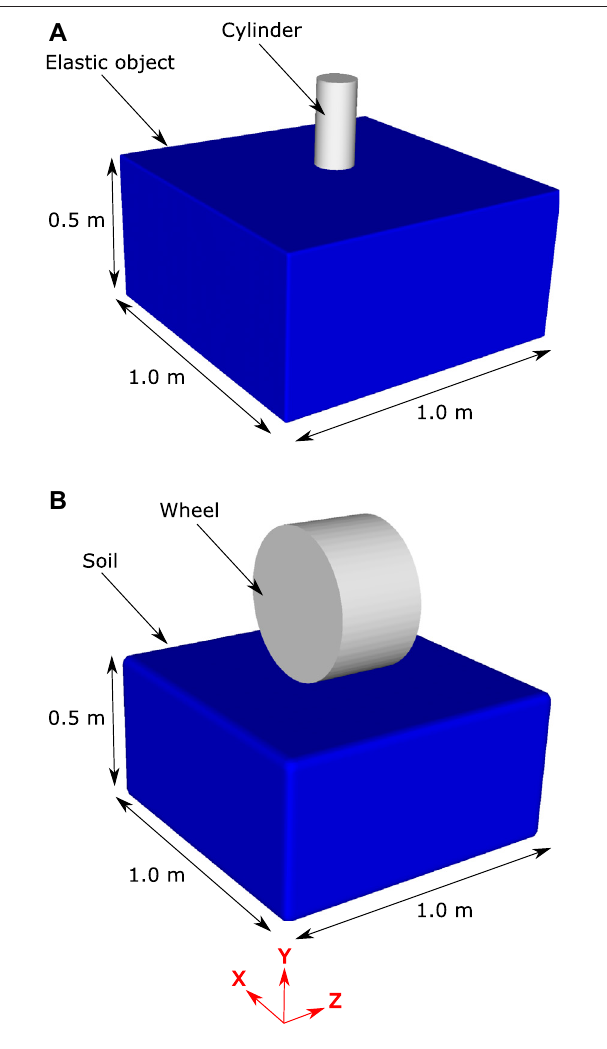
FIGURE 4 | The two simulation con fi gurations used in the veri fi cation and validation analysis. Panel (A) shows the con fi guration for cylindrical indentation of an elastic solid “ soil ” . Panel (B) shows the con fi guration for the indentation of an elastoplastic solid by a rigid